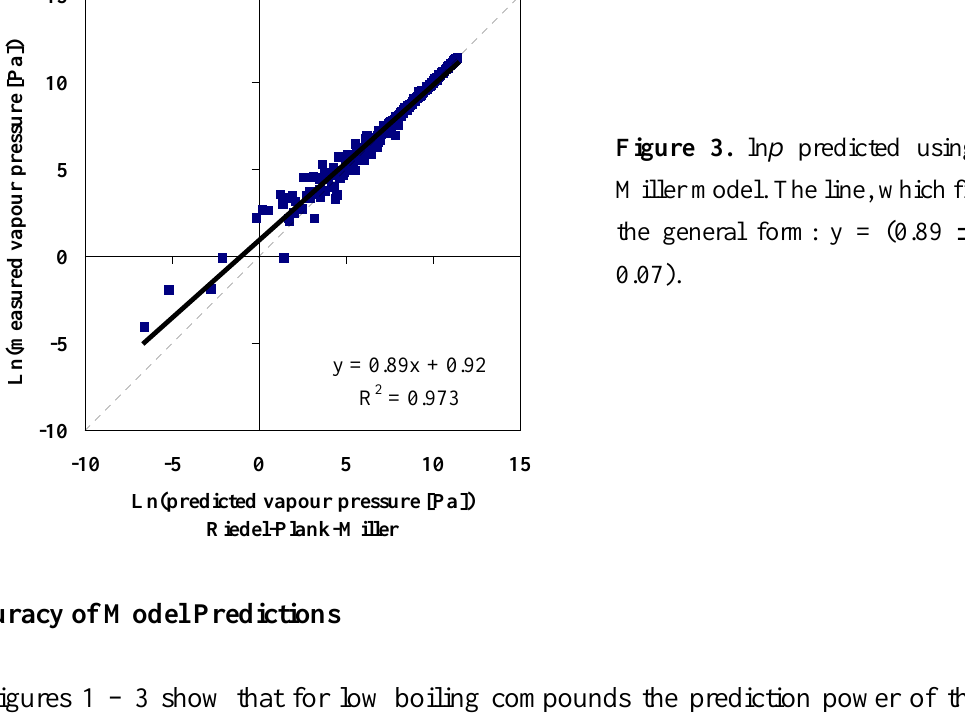
Figure 3. ln p predicted using the Riedel-Plank- Miller model. The line, which fits the data best, is of the general form: y = (0.89 ± 0.01) x + (0.92 ±